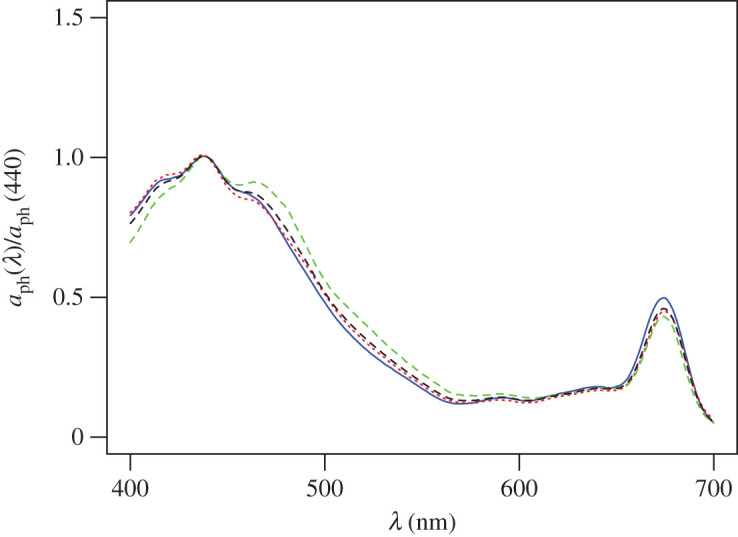
Mean in vivo light absorption spectra normalized to 440 nm (aph(440)) for natural phytoplankton assemblages from the Barents (blue solid line), Labrador (red dotted line) and Greenland/Norwegian Seas (green dashed line). The black dashed line shows the average shape for the Atlantic Arctic region used in the primary production model to represent both phytoplankton light absorption and the spectral dependence of light-limited photosynthesis.